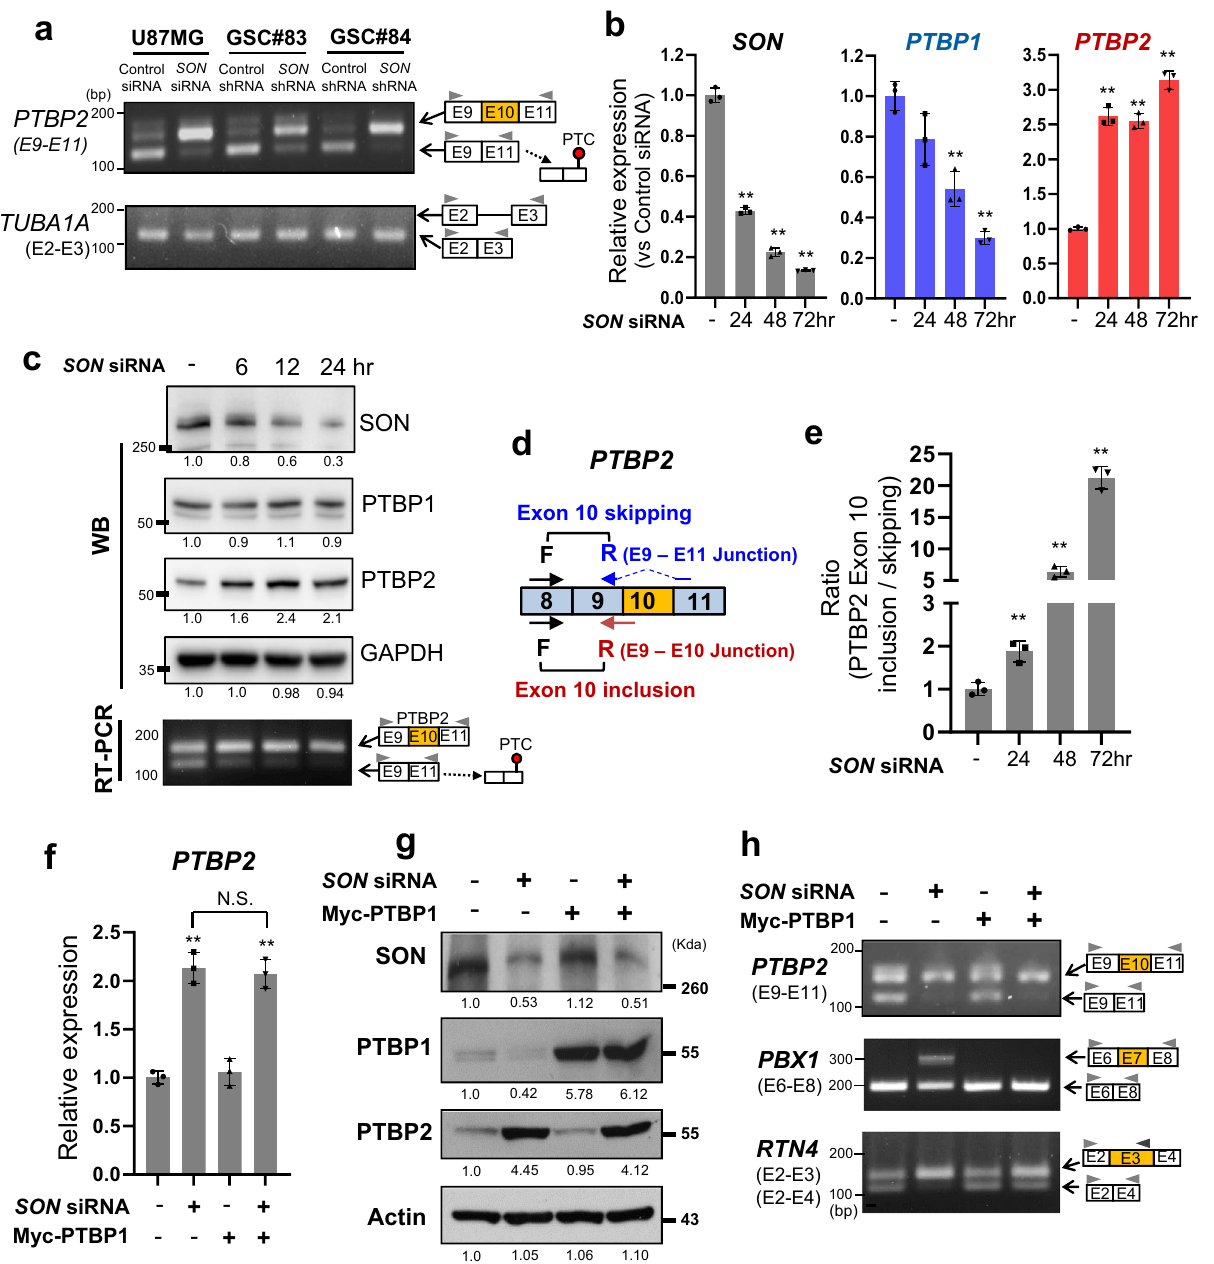
relative band intensity. Source data are provided in the Source data fi